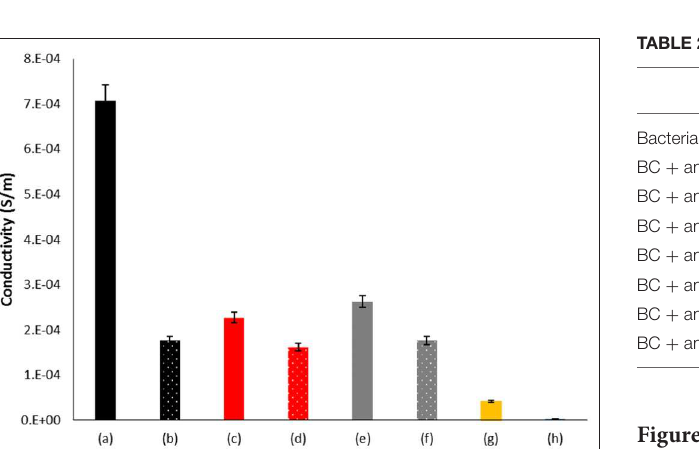
Figure 2 . The oxidation of aniline only in presence of laccase, in absence of any template, gave a disordered crystal-like structure, attributed to the irregular branched polymerization of aniline. The oxidation in the presence of templates gave rise to differentiated structures. The polymerization of aniline in the presence of KCHF resulted in microspheric structures, corresponding to smaller species, whilst the oxidation in the presence of both templates resulted in structures similar to one dimension nanofibers and three dimensional granules. The resulting structures are in accordance with what has been described for small and bigger oxidized species, respectively. As depicted in Figure 2 , the structure of PANI samples obtained in the presence of AOT alone was not easily visualized, probably due to the high micelles concentration which have constrained and uncovered the oligomeric/polymeric structures